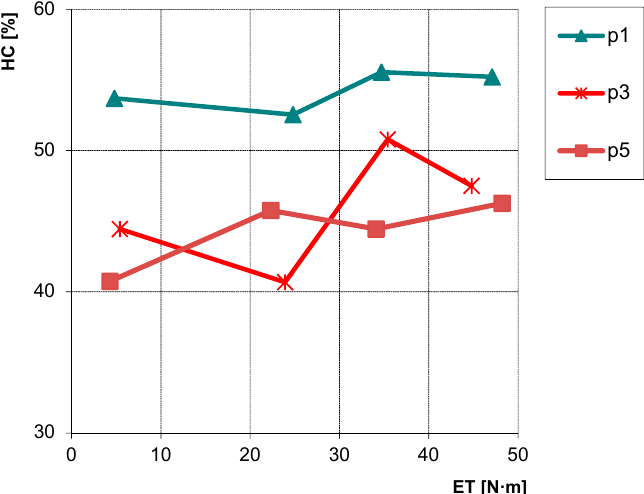
Figure 13. Changes in HC emissions under load characteristics.